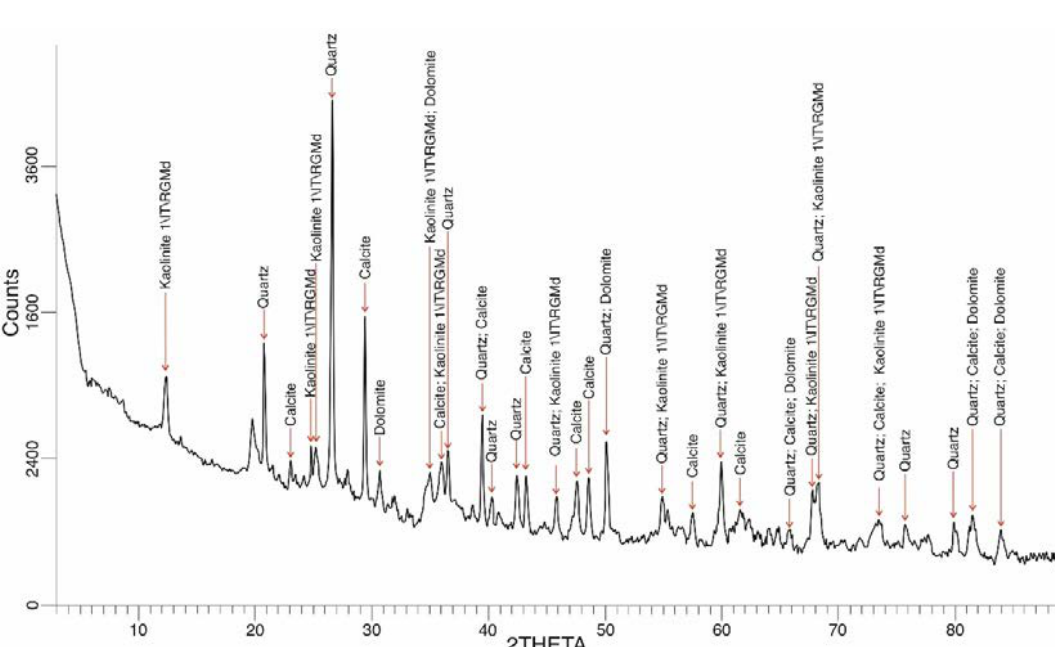
Fig. 2: X-ray diffraction of the studied sludge Fig. 2: X‐ray diffraction of the studied sludge